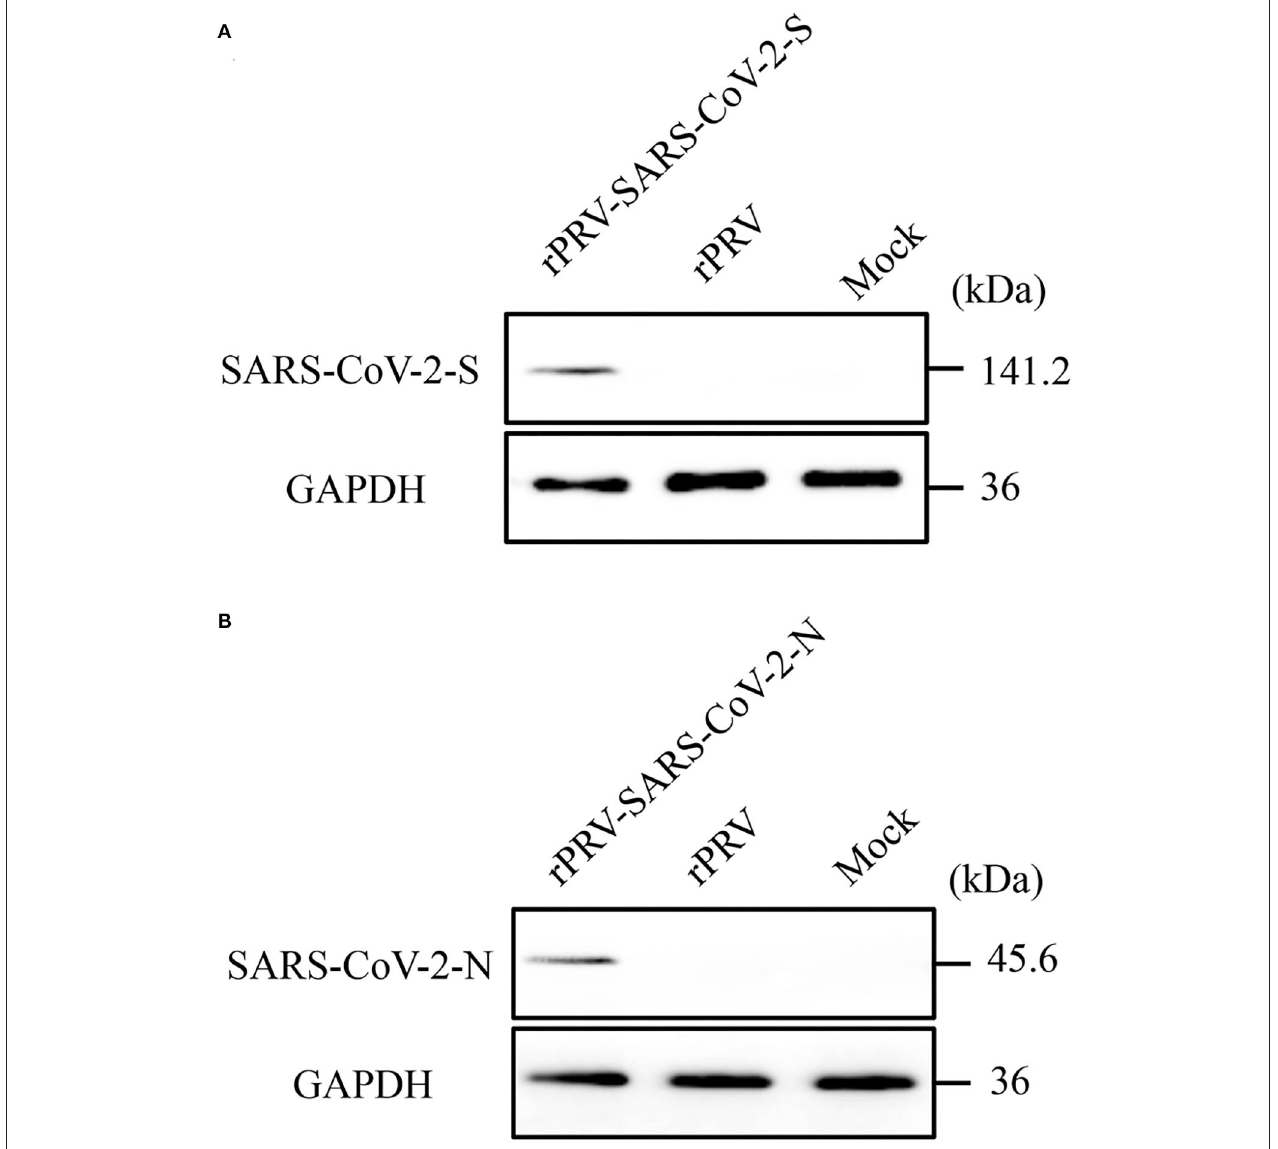
FIGURE 5 | Identification of recombinant viruses rPRV-SARS-CoV-2-S and rPRV-SARS-CoV-2-N by Western blot. After 48h, cell lysates were collected and analyzed by Western Blotting. Recombinant proteins were detected using a HA tag polyclonal antibody (1:1000 dilution) as the primary antibody and a HRP-conjugated anti-mice IgG (1:10000 dilution) as the secondary antibody. GAPDH was used as sample-loading control. (A) Protein expression using recombinant PRV-SARS-CoV-2-S. The molecular weight of rPRV-SARS-CoV-2-S was about 141.2 kDa; (B) Protein expression using recombinant rPRV-SARS-CoV-2-N. The molecular weight of rPRV-SARS-CoV-2-S was about 45.6